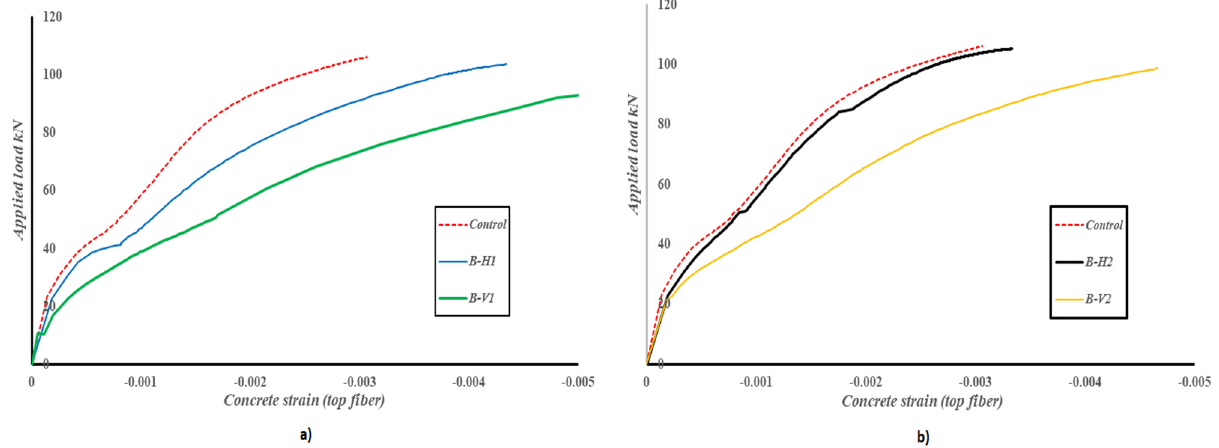
Figure 7: Load – concrete compressive strain for analyzed beams ( e ff ect of opening orientation ) . ( a ) Beams with one opening and ( b ) beams with two